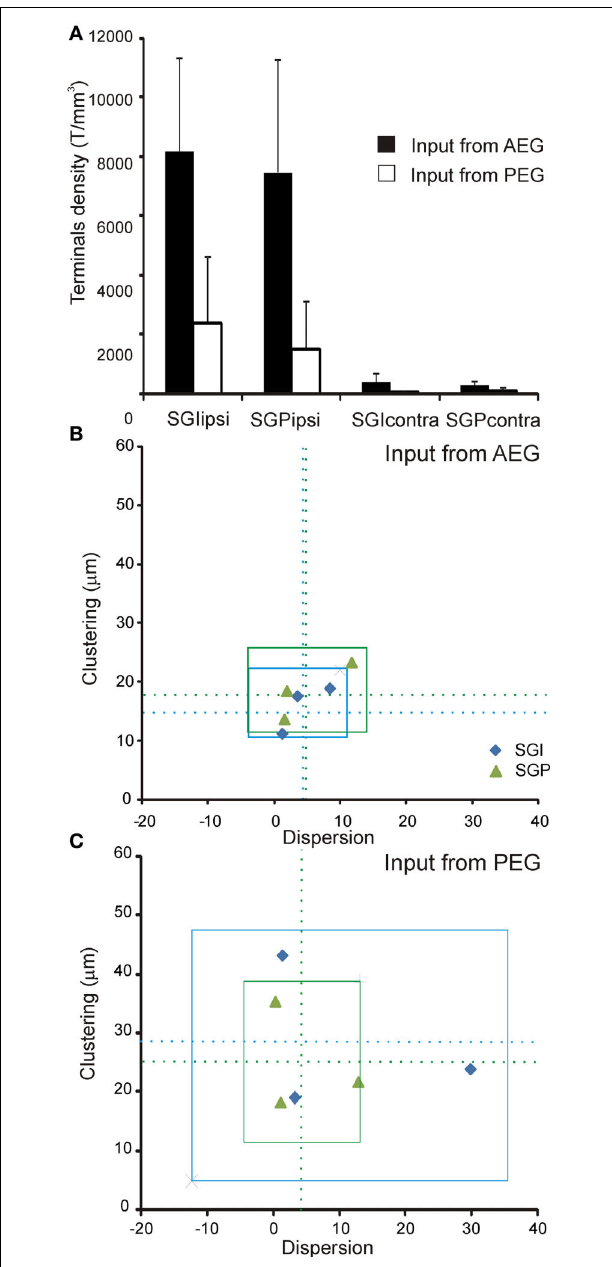
FIGURE 5 | Quantifi cation of the corticotectal inputs to the SC. Six cases with injection sites in the AEG ( n = 3) and PEG ( n = 3) were used for quantifi cation. (A) The normalized density of terminals (see Materials and Methods for details) is plotted in different layers of the left and right SC. The projection is predominantly uncrossed with a very minor contralateral component. No differences between the intermediate and deep layers of the SC (SGI and SGP) were found. The density of terminals was higher when input came from the AEG than from the PEG, but this difference was not signifi cant (ANOVA, F = 1.01, p = 0.46). For each individual case, the clustering index is (7,23) plotted against dispersion (measured as the ratio between the area of labeling in the SC and the area of the injection site in the cortex). These measures show that terminals from AEG (B) tend to be more clustered and less dispersed than terminals from PEG (C) . Dotted lines in (B) and (C) represent the mean and the squares represent three times the standard deviation of the mean; terminals in SGI are shown in blue and terminals in SGP in